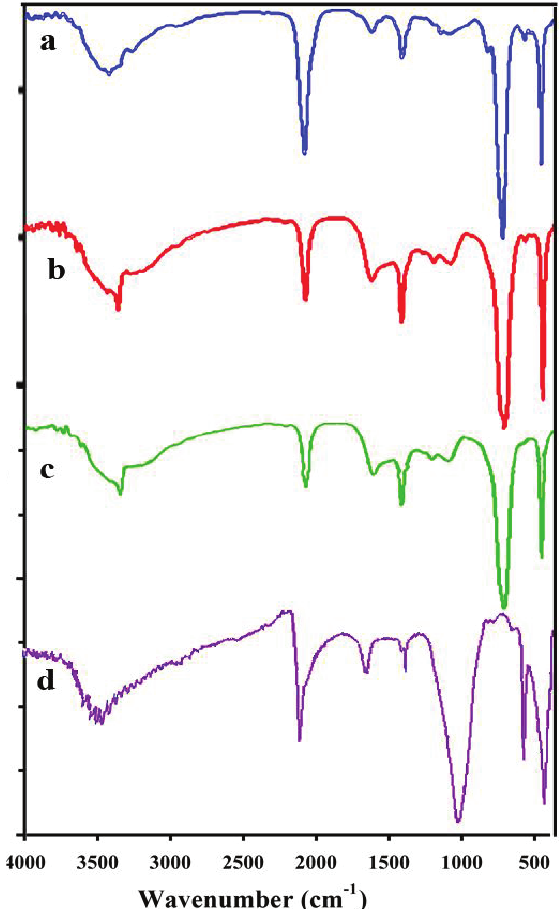
Fig. 4. FT-IR spectra of the prepared magnetite nanoparticles by two methods; solvothermal in different times: 12 h (a), 24 h (b), 36 h (c), and hydrothermal for 12 h (d) at 200˚C.